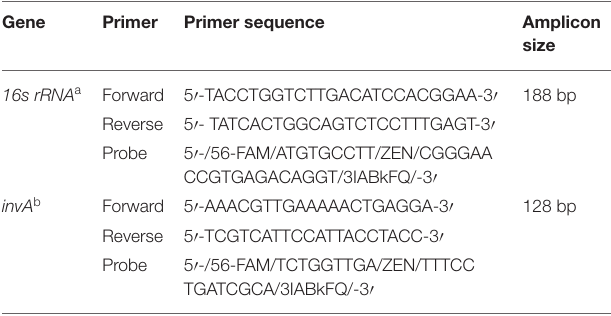
TABLE 2 | Primer sequences used for quantification of 16s rRNA and invA genes in fecal samples from dairy cows.